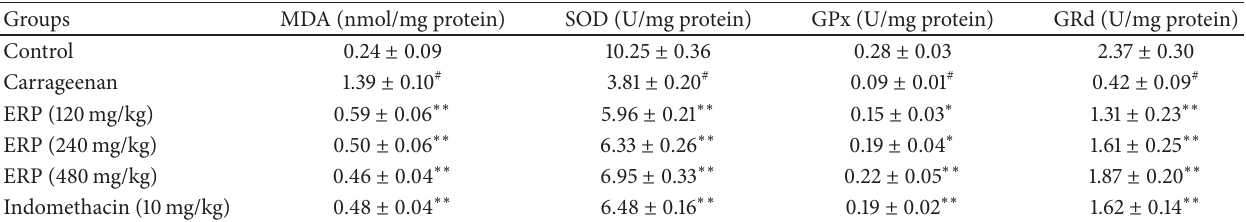
Table 2: Effect of ERP on carrageenan-induced the level of MDA in mouse paw edema and the activities of SOD, GPx, and GRd in mouse liver.